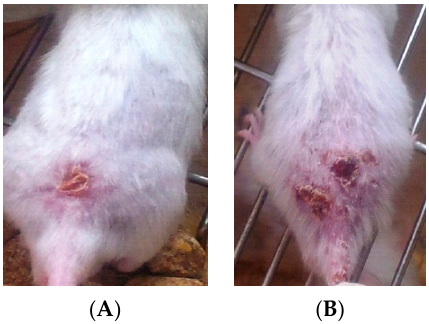
Figure 2. ( A , B ) Cutaneous leishmaniasis scars of Bagg Albino genotype c (BALB/c) mice appeared on the skin of mice four weeks after injection.